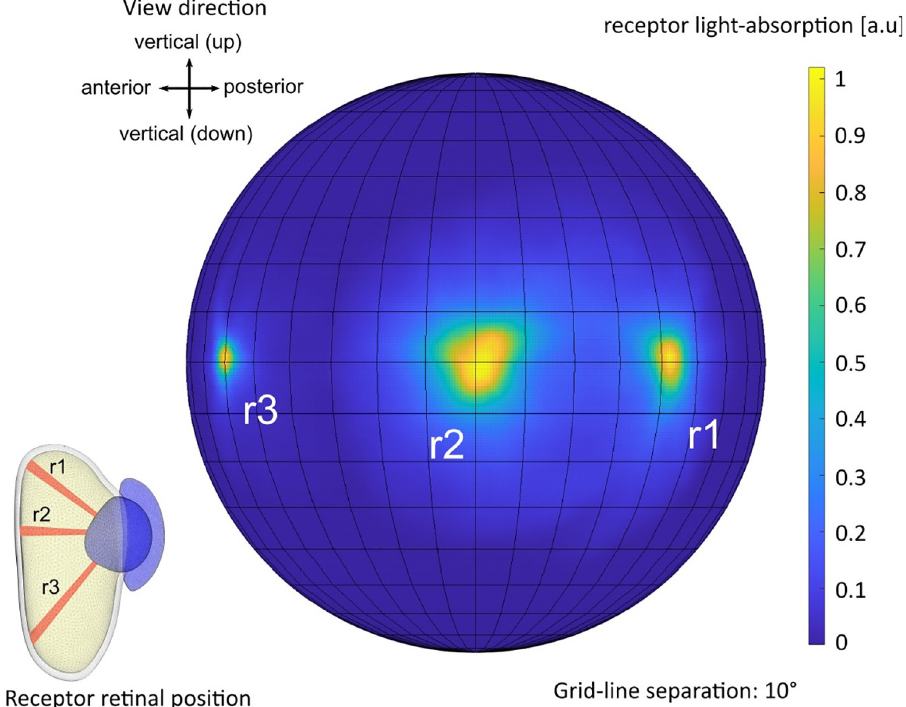
Fig 5. Single receptor angular sensitivities. Spherical orthographic projection heat maps of the angular sensitivity calculated for three individual photoreceptors. The receptor light-absorption scale is normalized separately for each receptor. The receptors r1, r2 and r3 are positioned in the front, centre and back of the retina respectively.